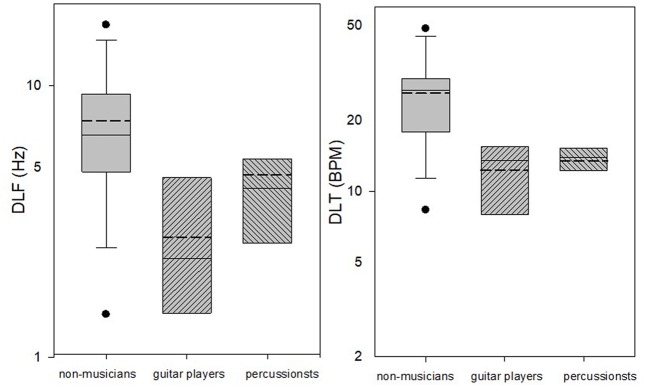
Box plots of the mean last two measurements (4 and 5) in the DLF and DLT tasks of the guitar players and percussionists (second experiment) compared to the non-musicians (first experiment). Box limits include the 25th–75th percentile data. Continuous line within the box represents the median. Dashed line within the bars represents mean. Bars extend to the 10th and 90th percentiles. Black dots represent outliers.